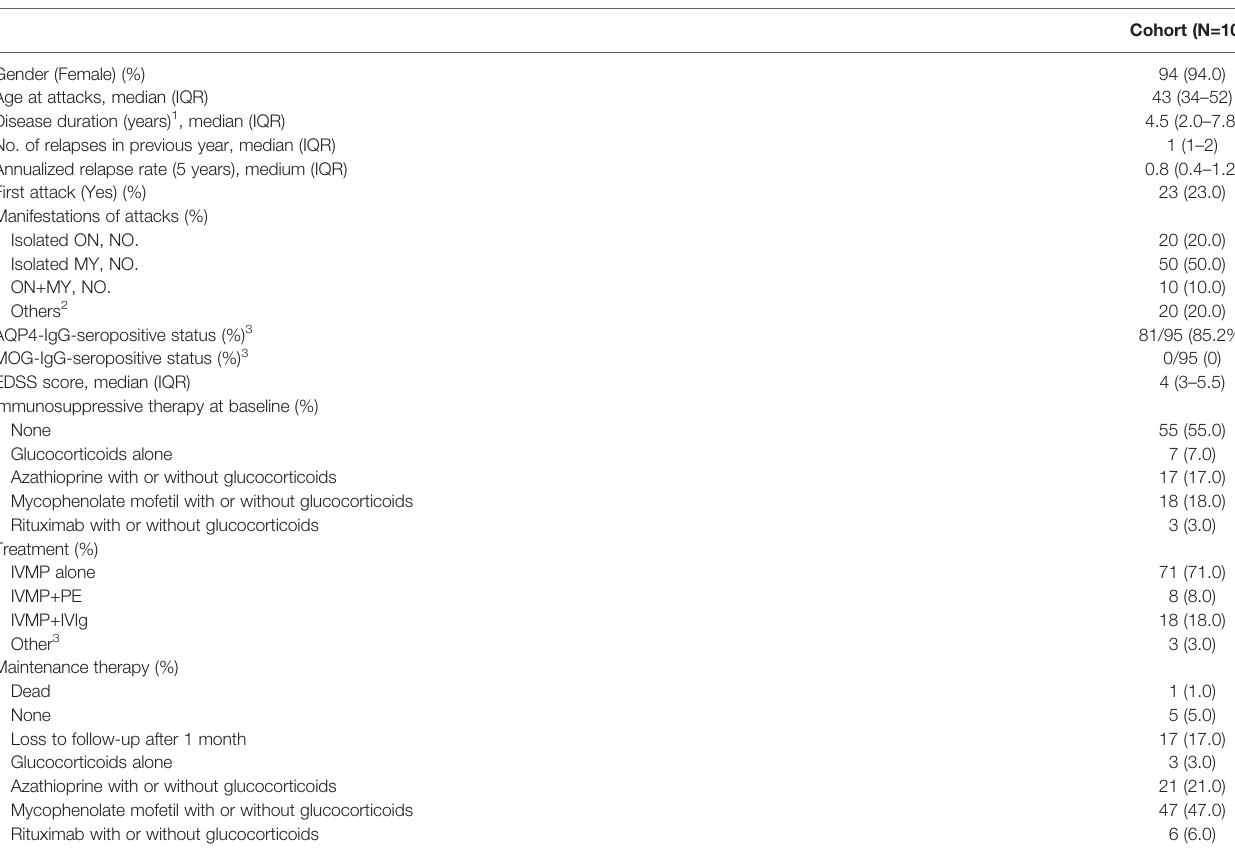
TABLE 1 | The baseline demographic and clinical characteristics of NMOSD